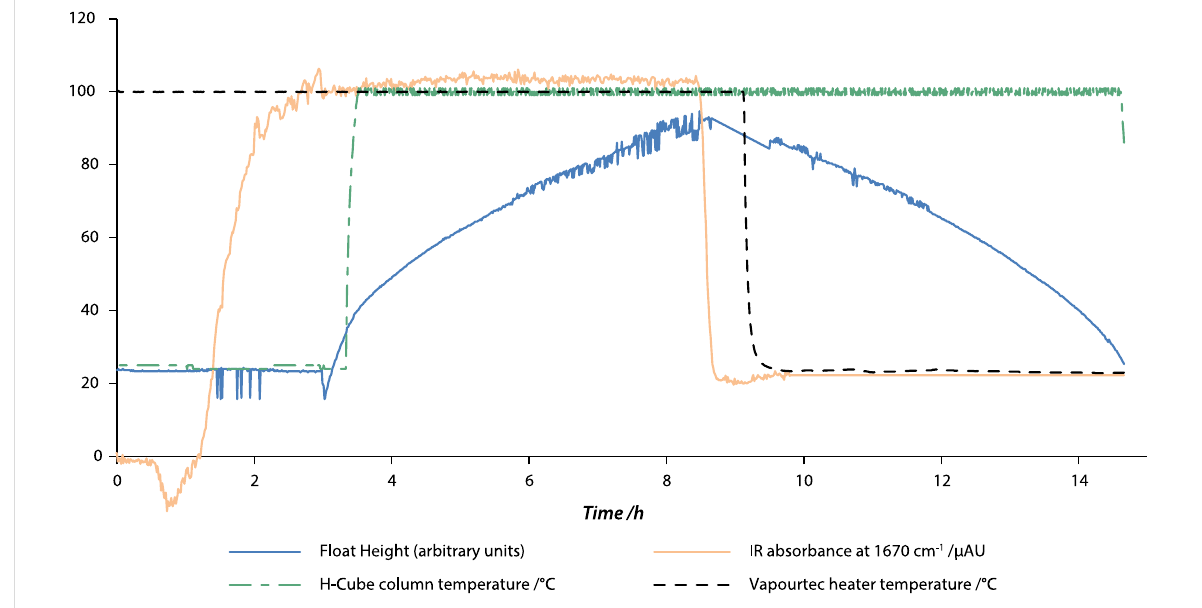
Figure 14: Chart of monitored parameters over a 15 hour reaction. The output from the hydrolysis step is directed into the reservoir as soon as the IR absorption crosses a threshold. When enough material has been collected, the H-Cube ® is powered on and the hydrogenation step is started. When the reservoir fills up the first step is stopped. The hydrogenation continues until the intermediate has been used